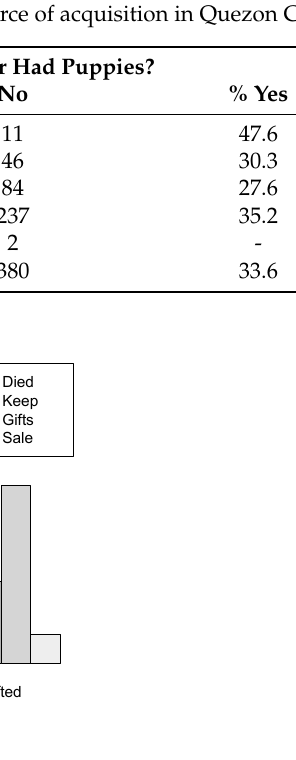
Figure 8. Puppy fate by mother acquisition source for Quezon City.